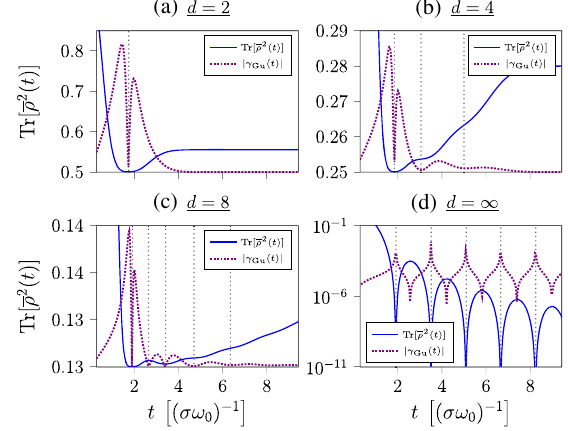
FIG. 6. Decay of the purity Tr ½ ¯ ρ 2 ð t Þ(cid:2) to its asymptotic value (blue solid line) and of the absolute value of the depolarization t Þj (purple dashed line), for the GUE ensemble for rates j γ GUE ð dimensions (a) d ¼ 2 , (b) d ¼ 4 , and (c) d ¼ 8 . For dimension (d) d → ∞ , the plot is semilogarithmic. All the depolarization t Þj are rescaled and vertically shifted for visualization rates j γ GUE ð purposes. The vertical, gray, dotted lines indicate the purity